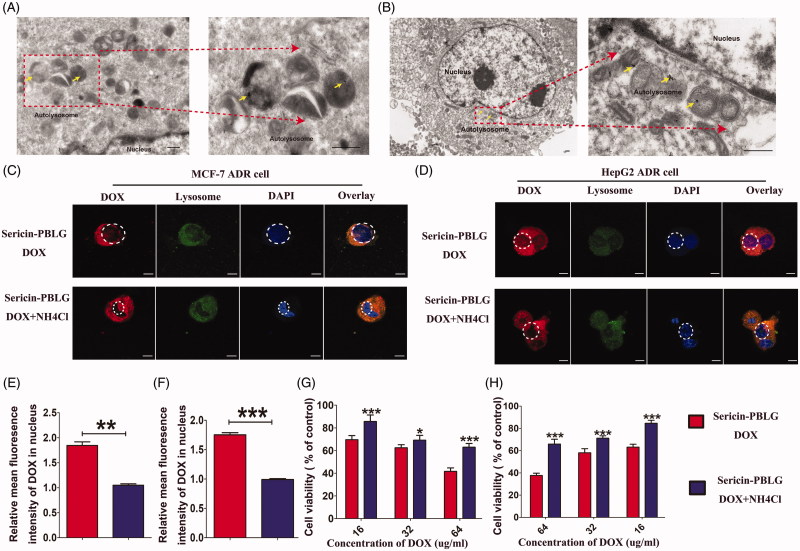
Intracellular distribution and pH-triggered drug release of sericin-PBLG-DOX. TEM images of MCF-7 ADR cells (A) and HepG2 ADR cells (B) after incubation with sericin-PBLG-DOX. Scale bar, 500 nm. CLSM images of MCF-7 ADR cells (C) and HepG2 ADR cells (D) with or without NH4Cl treatment in the presence of sericin-PBLG-DOX nanoparticles. Scale bar, 100 nm. The relative mean fluorescence intensity of DOX in the nucleus of MCF-7 ADR cells (E) and HepG2 ADR cells (F). Viability of MCF-7 ADR cells (G) and HepG2 ADR cells (H) with or without NH4Cl treatment in the presence of sericin-PBLG-DOX nanoparticles. The yellow arrows represent nanomicelles. Data are shown as the mean ± SD, n = 3. * indicates p < .05, ** indicates p < .01, and *** indicates p < .001.